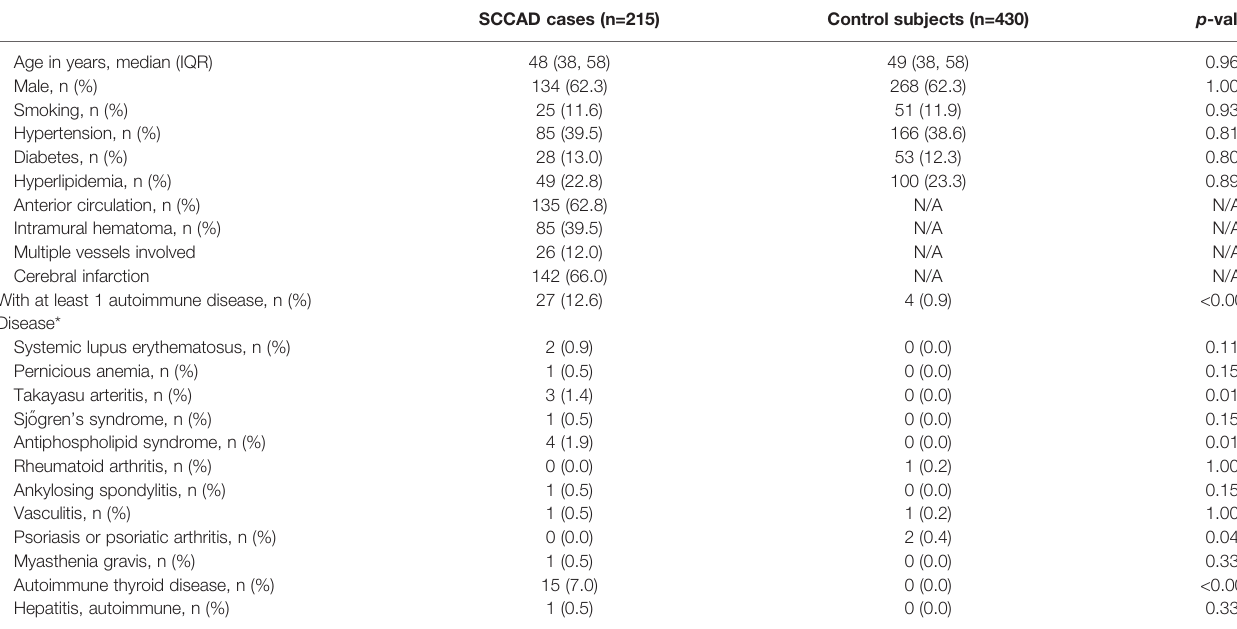
TABLE 1 | Characteristics and autoimmune diseases of all 215 cases with SCCAD and their control subjects of fi rst SCAD event. SCCAD cases